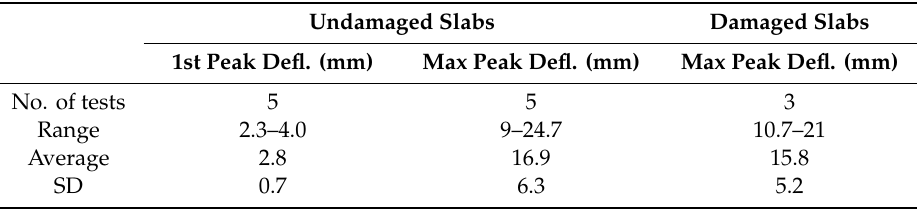
Table 6. Deflection average value and standard deviation.